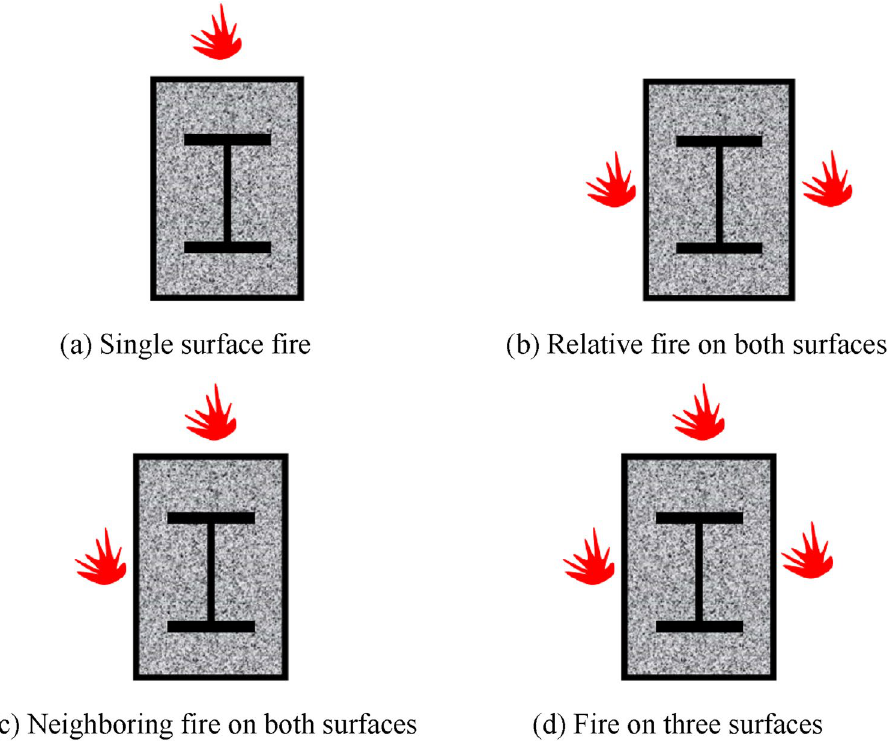
Figure 2. Schematic diagram of non-uniform fire